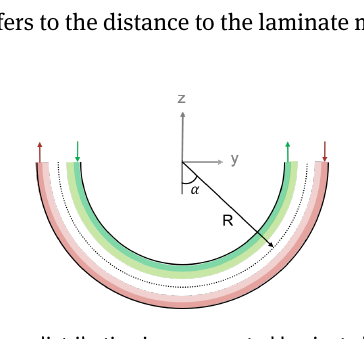
Figure 11: Stress distribution in a corrugated laminate half-cell sub- jected to torsional loading. The plot shows the relevant parameters known in shell theory models.